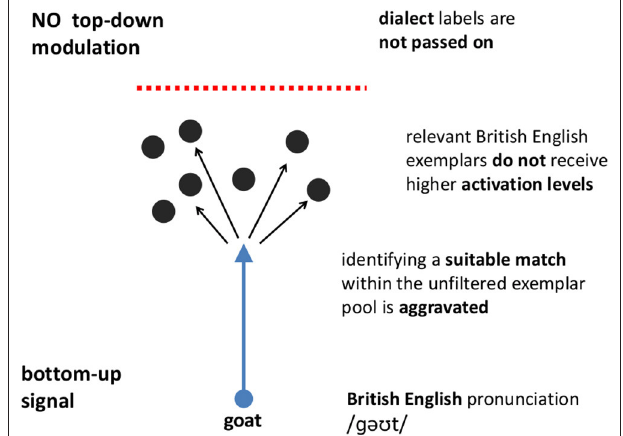
FIGURE 4 | Switch costs in the Simon Test with color-coded native speaker conditions.